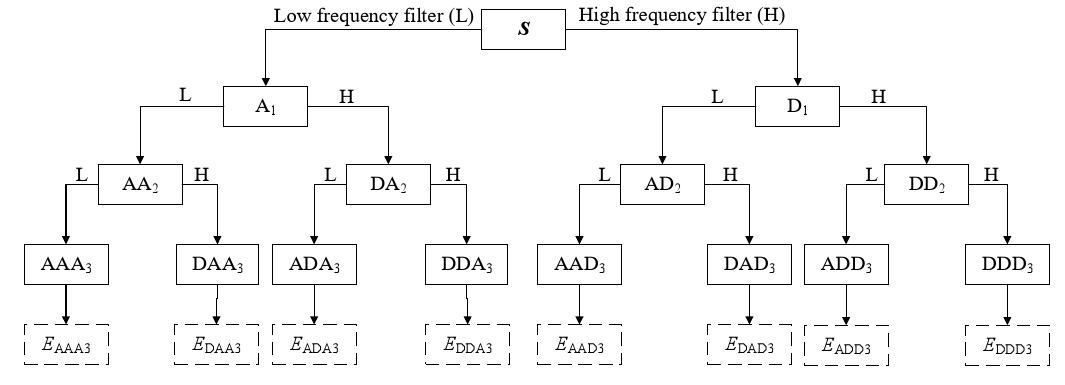
Figure 13. Wavelet packet decomposition process.